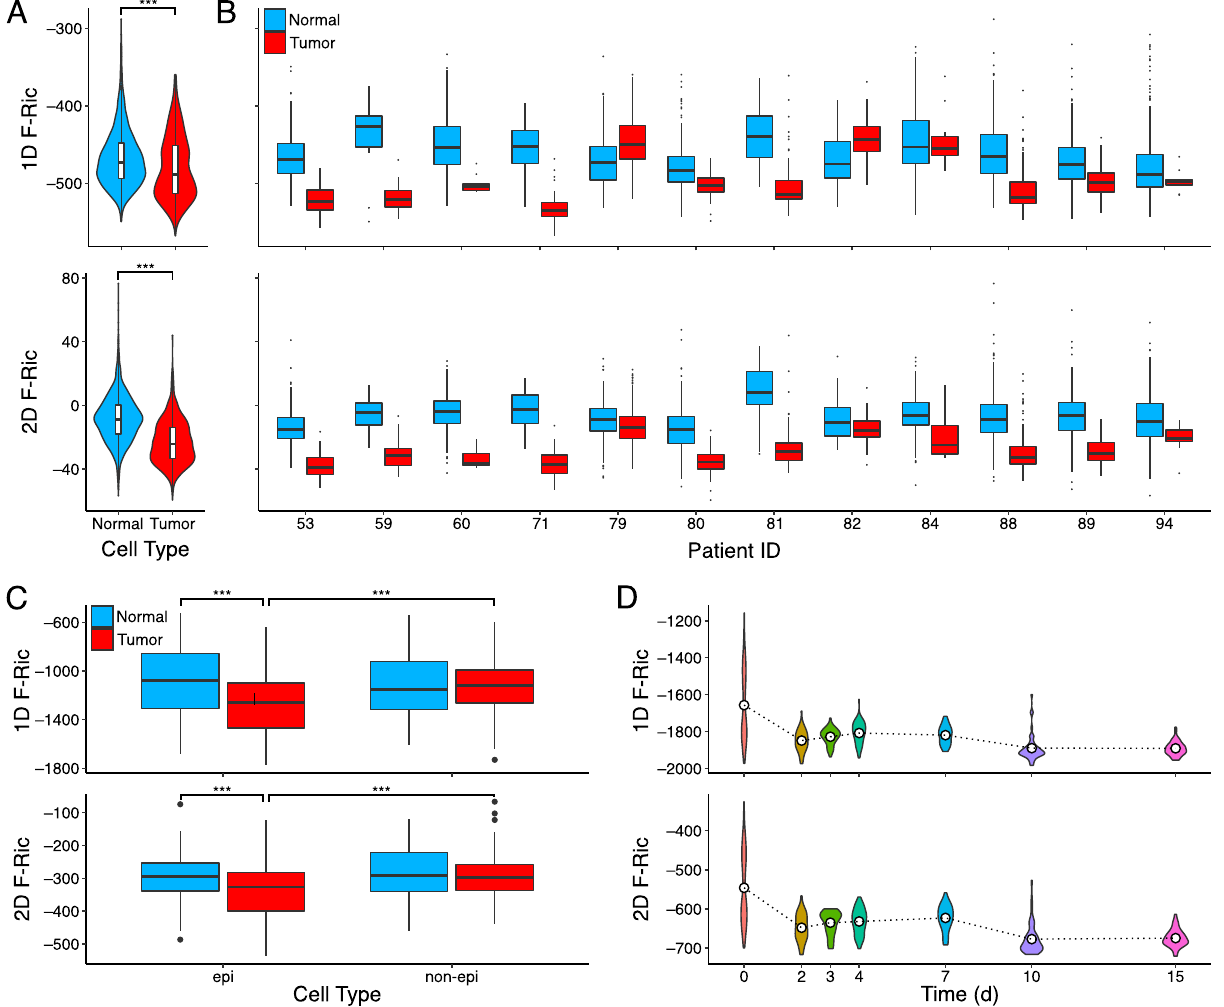
Figure 4. Global PPI network geometry in cancer. ( A ) Violin plots of PPI network global average Forman-Ricci curvature in the 1D graph model (1D F-Ric) and 2D simplicial complex model (2D F-Ric) of all normal (blue) or tumor (red) cells from melanoma patients. ( B ) Box plots of 1D F-Ric and 2D F-Ric separated by individual patients. ( C ) Box plots of 1D F-Ric and 2D F-Ric in epithelial (epi) and non-epithelial (non-epi) cells of normal (blue) and tumor (red) samples from colorectal cancer patients. ( D ) Violin plots of 1D F-Ric and 2D F-Ric across time points after induction of EWSR1-FLI1 oncogene in A576 cells. Dotted lines are means at each time point. *** indicates p < 0.001